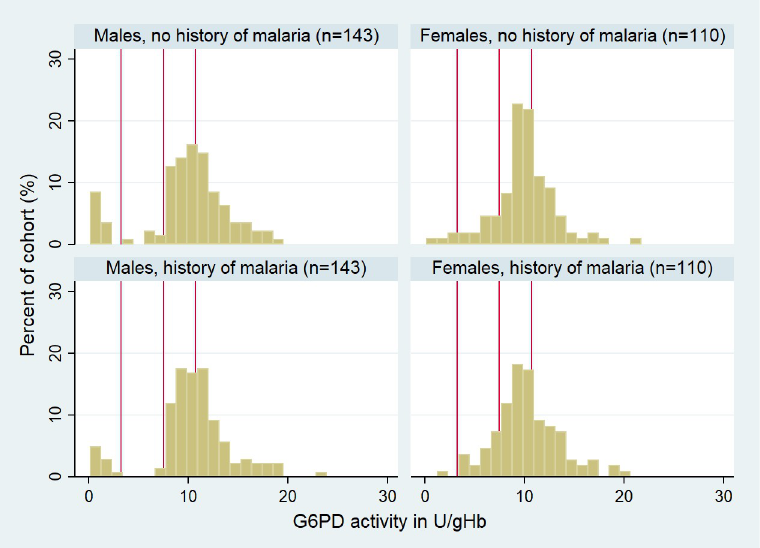
Fig 4. Distribution of G6PD activity stratified by sex in cases and controls. Red vertical lines indicate 30%, 70%, and 100% G6PD activity of the adjusted male median. G6PD, glucose-6-phosphate dehydrogenase.